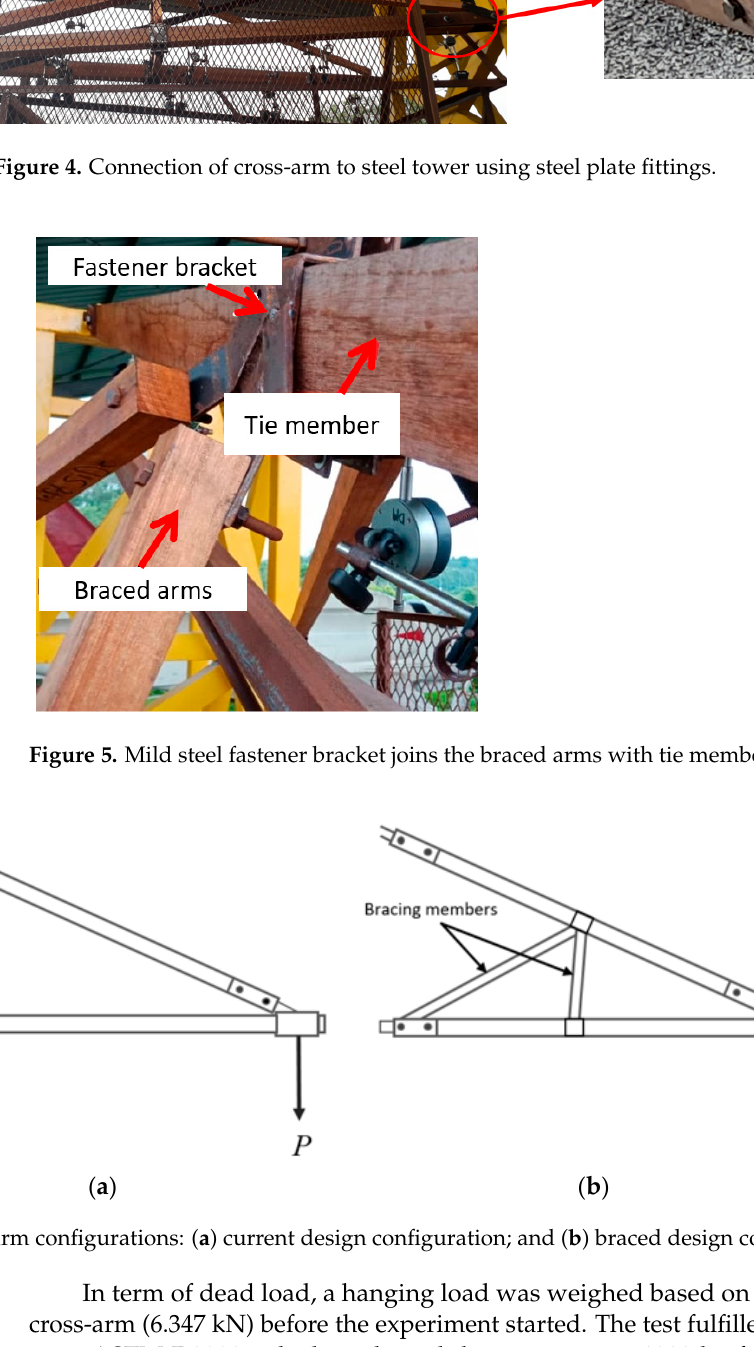
Figure 4. Connection of cross-arm to steel tower using steel plate fittings.